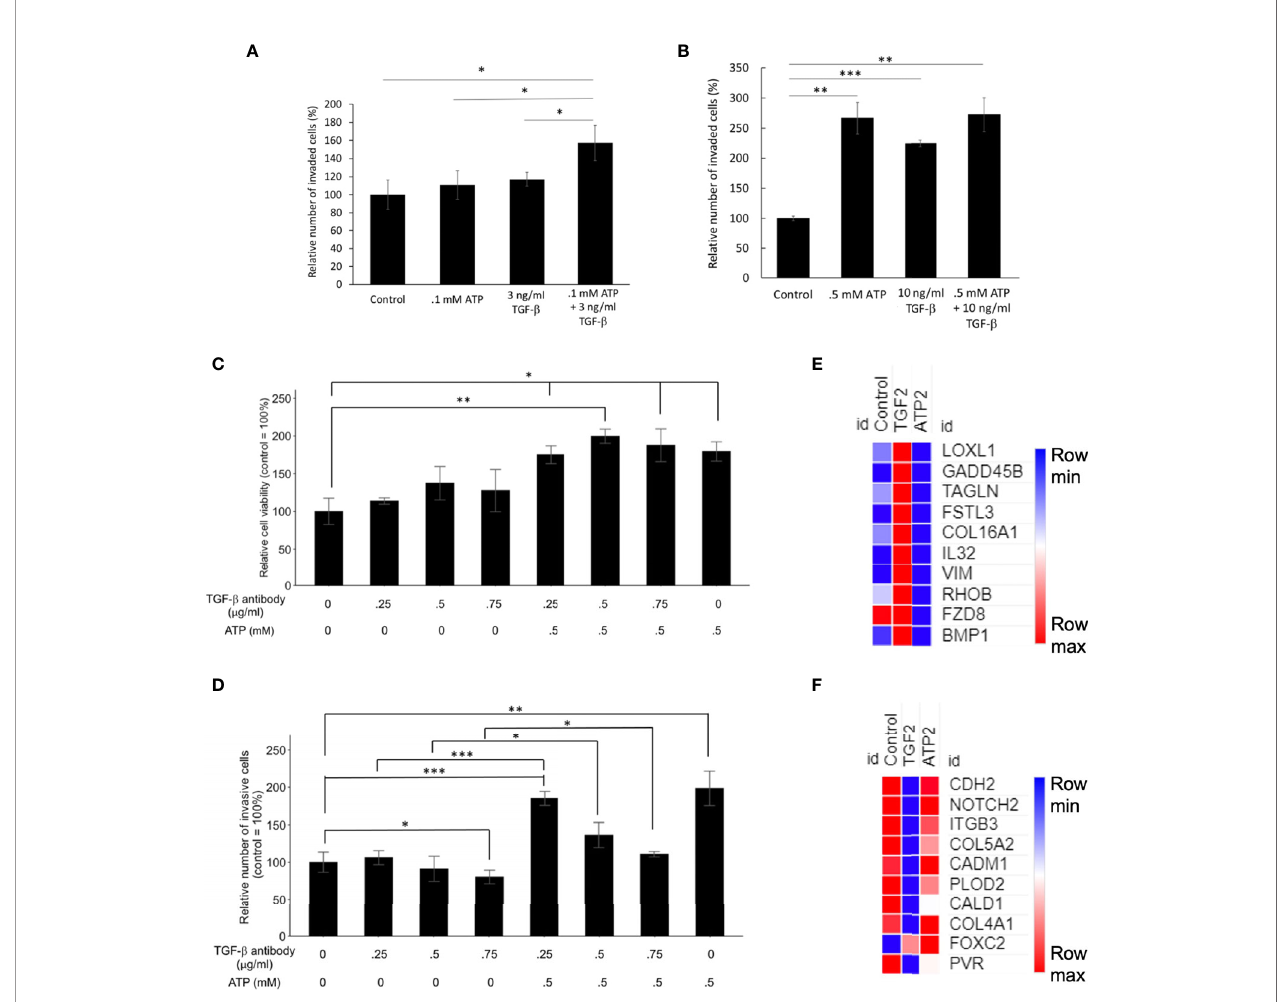
FIGURE 5 | Mechanism study I: Similarities and differences in EMT induced by eATP or TGF- b . Human NSCLC A549 and/or H1299 cells grown in either regular cell culture plates or transwell plates were treated with either ATP, TGF- b , or both at various concentrations and measured for their respective intracellular ATP levels or additive effect in the invasion assay. In a different study, A549 cells were treated with anti-TGF- b neutralizing antibody at various concentrations in the presence or absence of different concentrations of eATP. 24 hours after the treatment, treated cells were assayed for their intracellular ATP levels or their cell viability by resazurin assay. *P < 0.05, **P < 0.01. ***P <.001. (A, B) eATP and TGF- b show an additive effect in inducing invasion at lower concentrations (A) while eATP and TGF- b do not show an additive effect in inducing invasion at higher concentrations (B) . (C, D) Extracellular ATP increased cell viability of cells treated with TGF- b neutralizing antibody (C) . Extracellular ATP restored the invasiveness of A549 cells treated with TGF- b antibody (D) in A549 cells. (E, F) Heatmaps of EMT-related genes upregulated by TGF- b at 2 hours (E) , and EMT-related genes upregulated by ATP at 2 hours (F) . The FPKM values of three replicates of each gene are shown in Supplemental Tables 5 , 6 ,